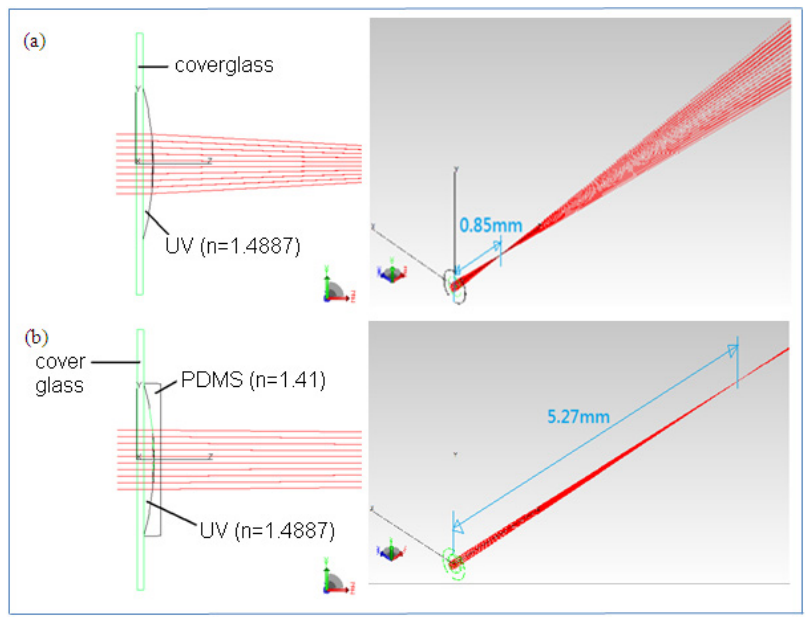
Figure 2. Ray tracing simulation by Tracepro ® of 235 μ m diameter MLA (a) without cover layer and (b) with a PDMS cover layer on